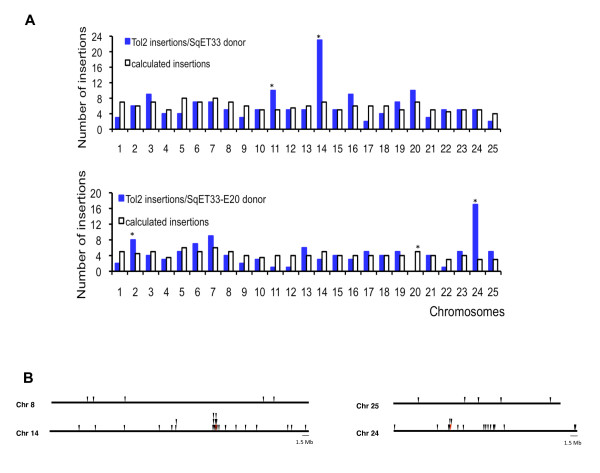
Genome-wide distribution pattern of Tol2 integrations. A: Chromosomal distribution pattern of Tol2 insertions depending on the donor site. Asterisks show statistically significant differences (p < 0.0001 for the donor chromosomes and p < 0.05 for the others). B: Pattern of Tol2 reintegrations linked to the different donor sites (chromosomes 14 and 24). Non-donor chromosomes 8 and 25, comparable in size to the donor chromosomes, are shown for reference. Red triangles represent the donor sites.